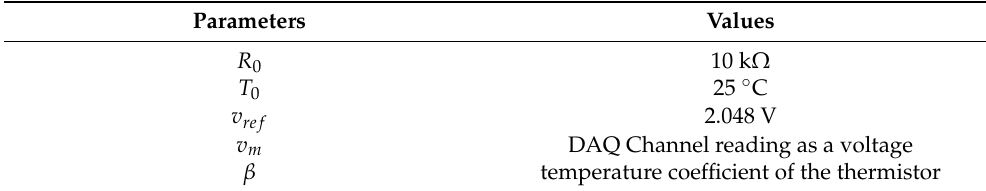
Figure 4. An in vivo measurement setup: ( a ) implanted coils underneath the skin, and ( b ) primary coils adhered above the skin. Table 3. The parameters used in Equations (6) and (7) to calculate the temperature from the recoded thermistor signals.